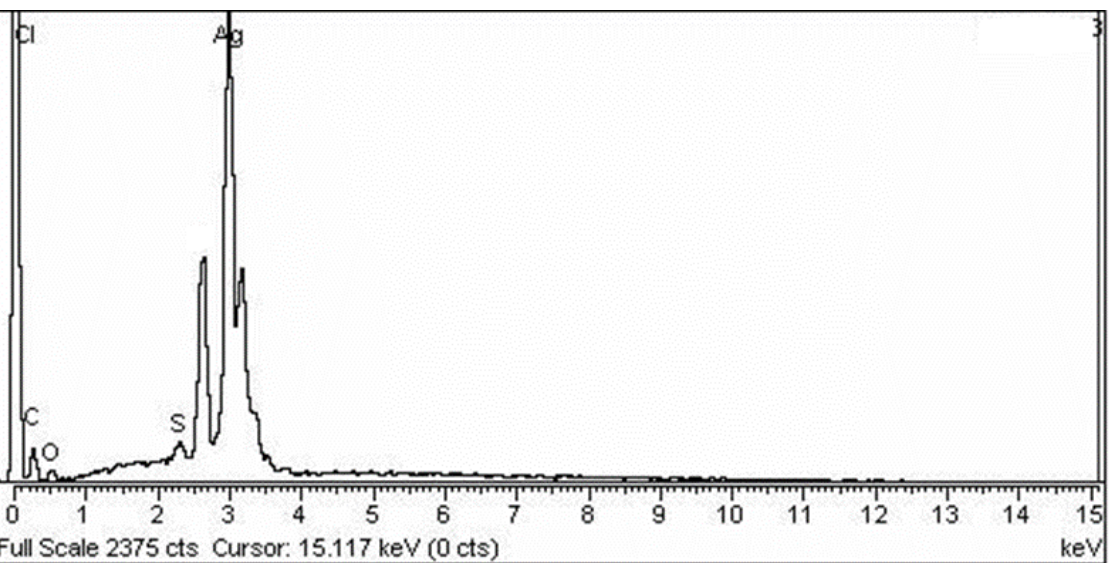
Figure 4. EDX analysis of the silver nano-powder.